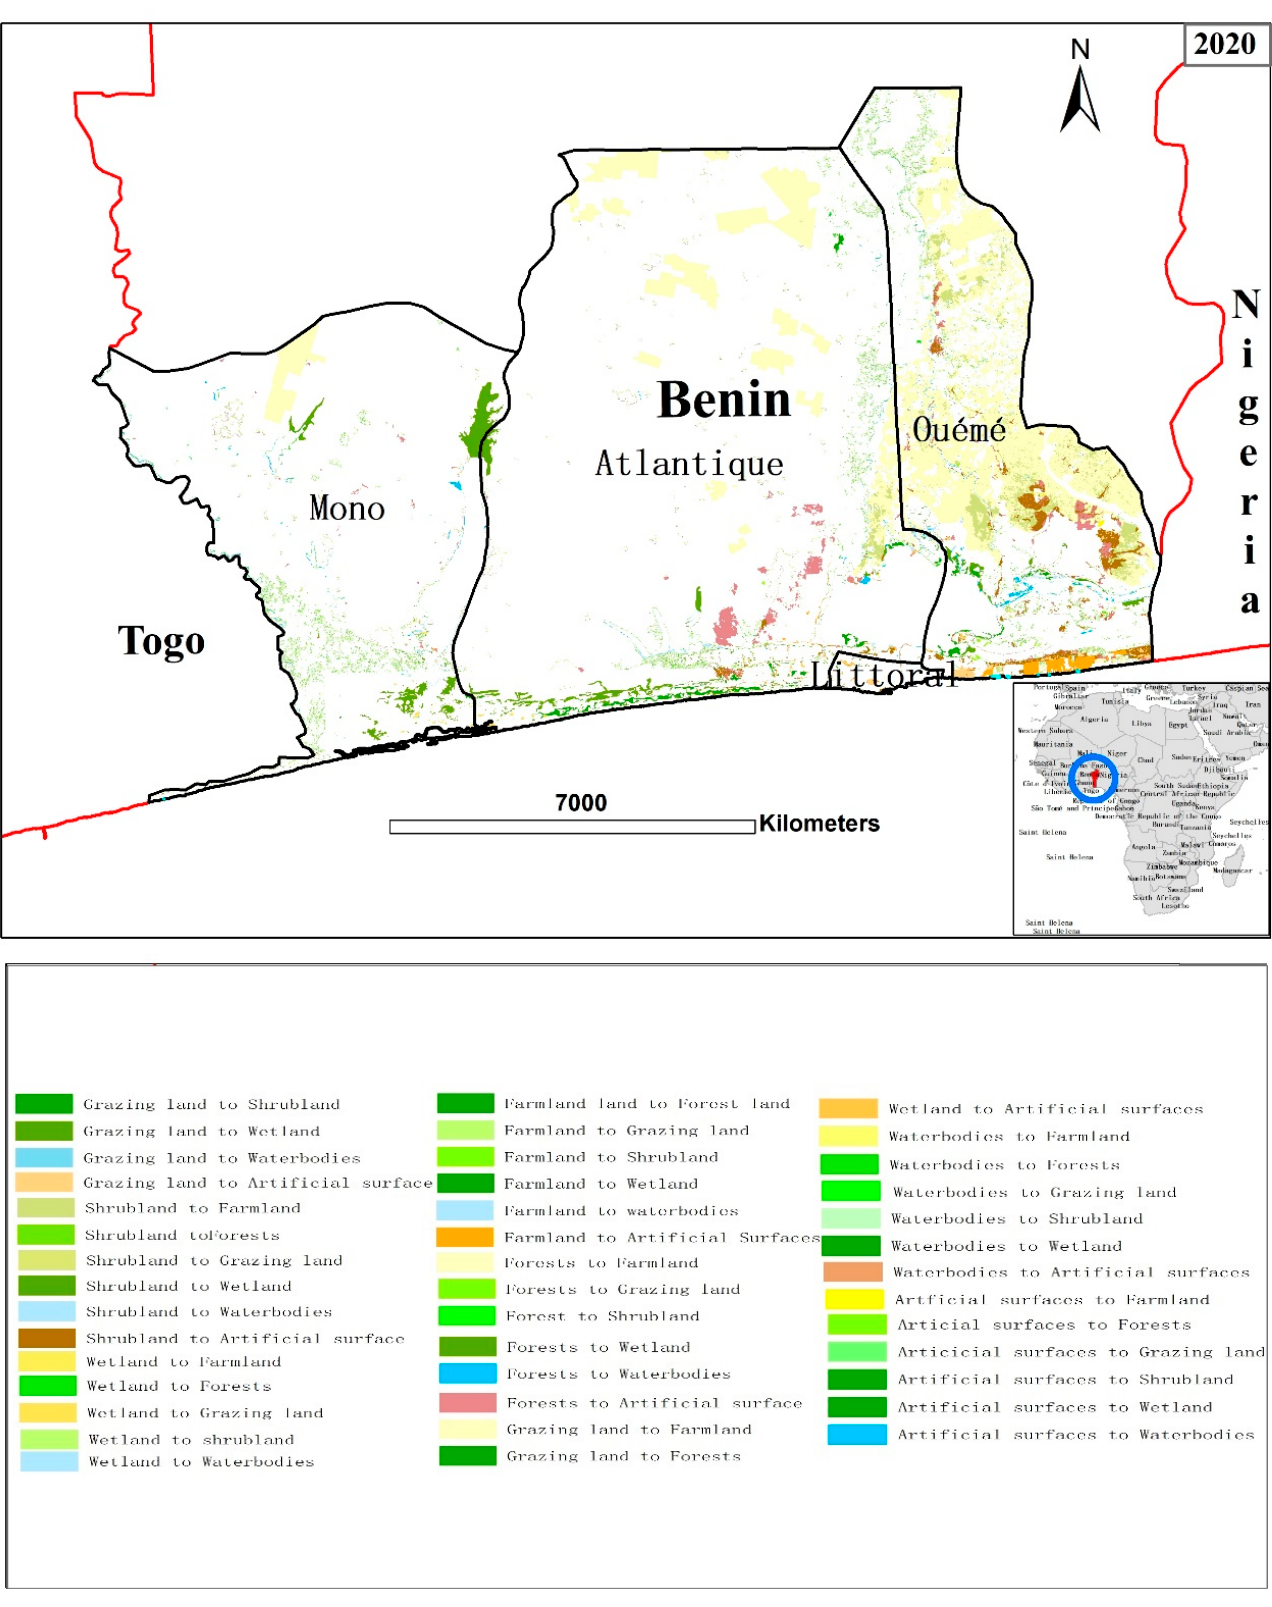
Figure 3. Transition patterns of land-use and land cover conversions in Benin.